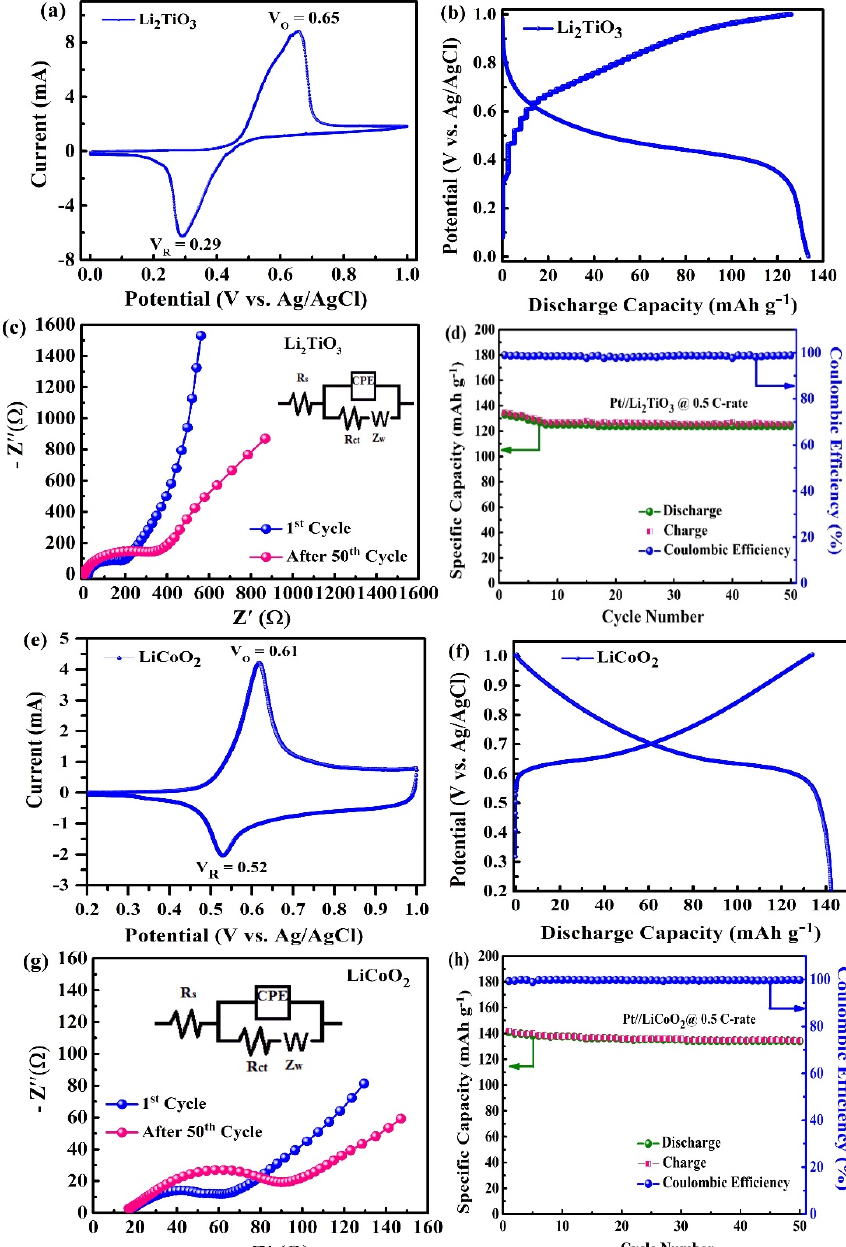
Figure 6. Electrochemical properties of ( a – d ) Li 2 TiO 3 //Pt half-cell and ( e – h ) LiCoO 2 //Pt half-cell in the potential range 0.0–0.1 V. ( a , e ) Cyclic voltammetry curves recorded at scan rate range of 1 mV s − 1 . ( b , f ) Galvanostatic charge-discharge (GCD) curves cycled at current rate of 0.5 C. ( c , g ) Electrochemical impedance spectrum (1st and after 50th cycle) with equivalent circuit (Inset). ( d , h ) Cyclability measured at current rate of 0.5 C for LTO ( d ) in the potential range 0.0–1.0 V vs. Ag/AgCl and for LCO ( h ) in the potential range 0.2–1.0 V vs. Ag/AgCl.